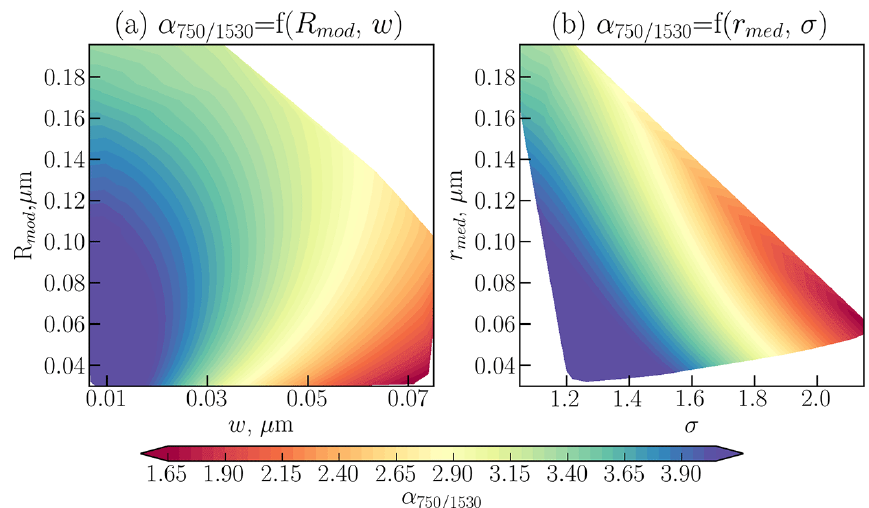
Figure 11. Dependence of the Ångström exponent ( α 750 / 1530 ) on mode radius, R mod , and absolute distribution width, w (a) . In panel (b) α 750 / 1530 as a function of median radius, r med , and σ is presented. Plot is based on the SCIAMACHY limb data in the tropics (20 ◦ N–20 ◦ S).